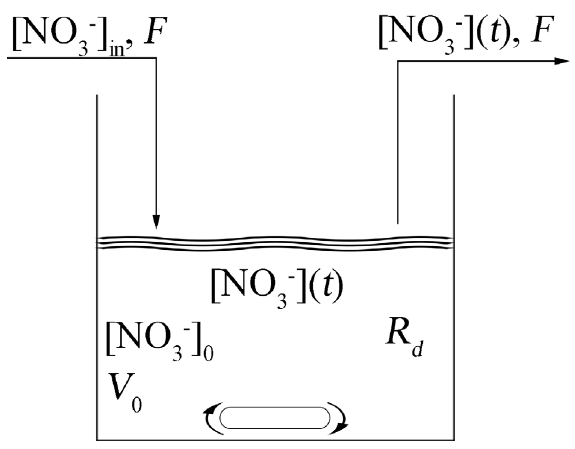
Figure 5. Scheme of the anoxic denitrification process in a Continuously Stirred Tank Reactor